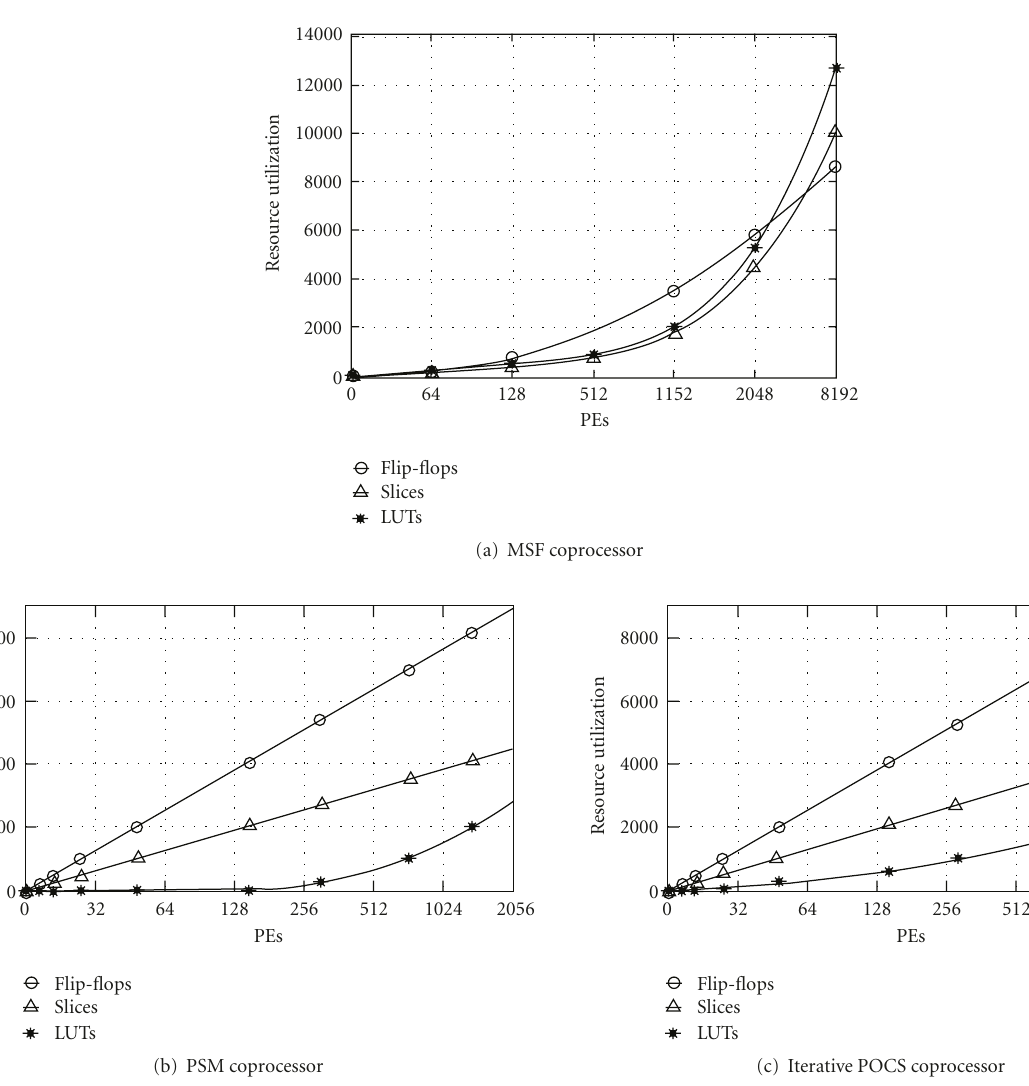
Figure 14: Resource utilization varying the number of